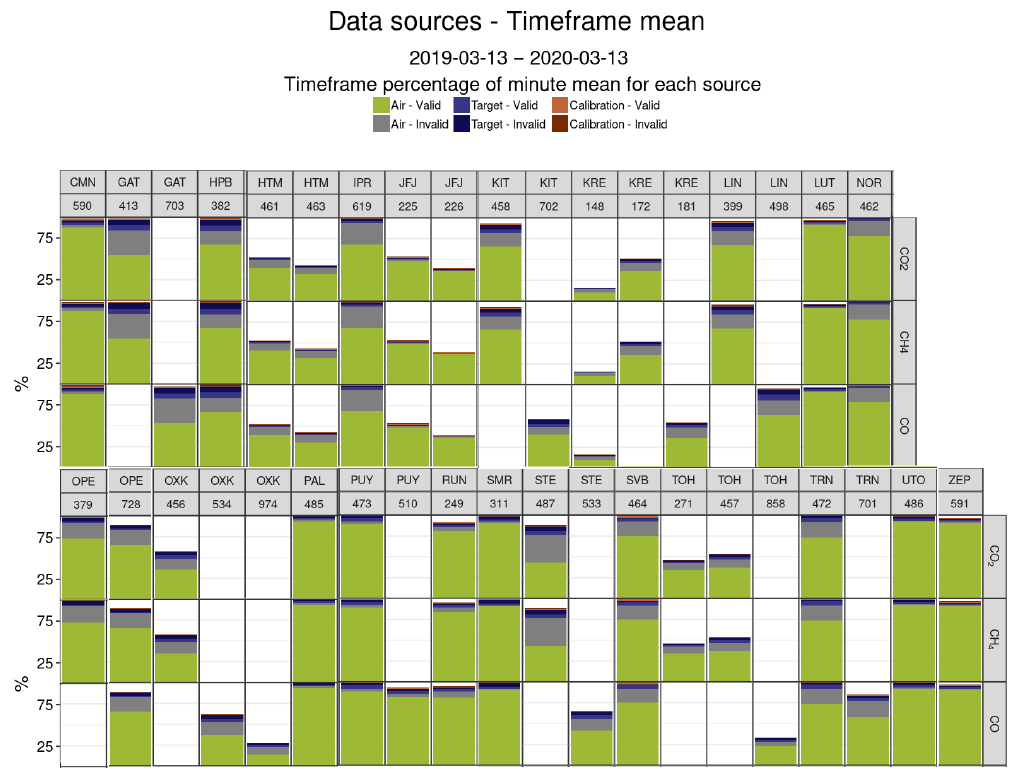
Figure 14. Data distribution between ambient air and target and calibration gases for the 23 stations for CO 2 , CH 4 and CO over the past year. Calibration is in red, target in blue and air in green/gray. Gray and darker colors are invalid data. The 100% level is reached when data are available for the full year. For some stations, two instruments are used to measure CO 2 , CH 4 and CO (see their ICOS ID on the second line). For others, due to instrumental failure, a new instrument replaced the previous one. See Table 3 for the acronyms and more details about each station.